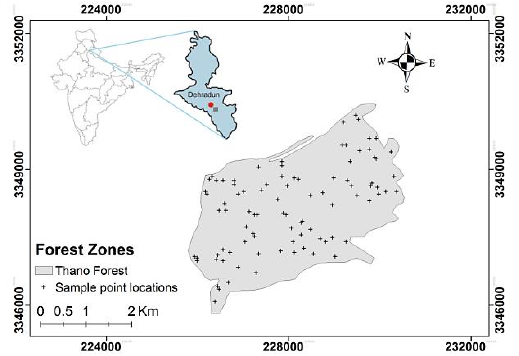
Figure 1: Location of study area along with sample points (N=100) within Thano forest site.